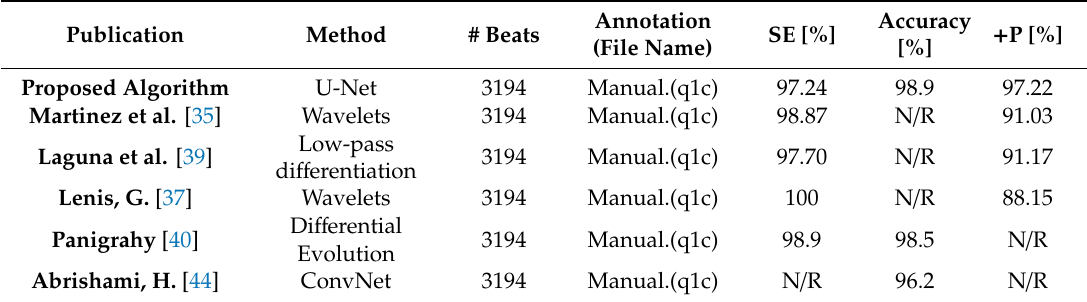
Table 6. P-wave detection performance comparison on the manual annotated QT database. [N / R: not